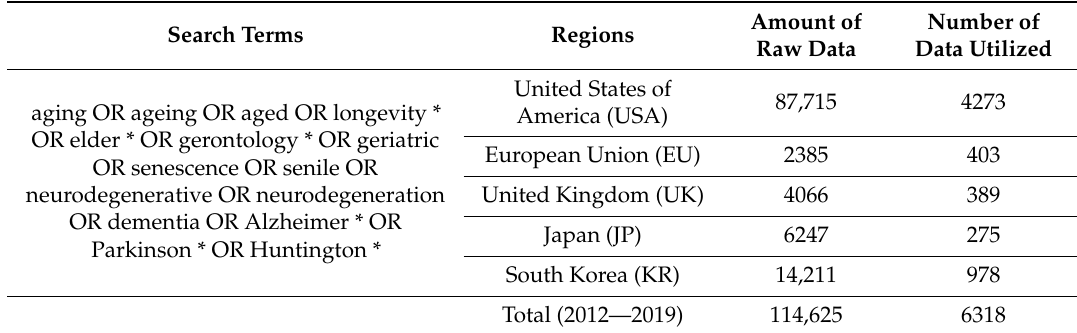
Table 1. Aging and aging-related national-funded project data and search terms.